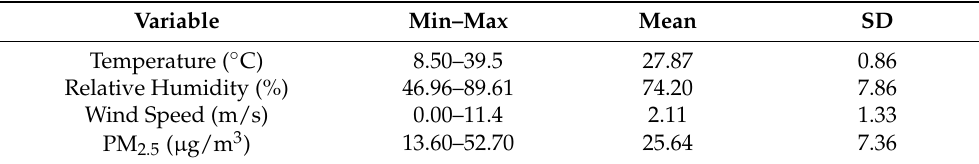
Table 3. Descriptive statistics of the main studied